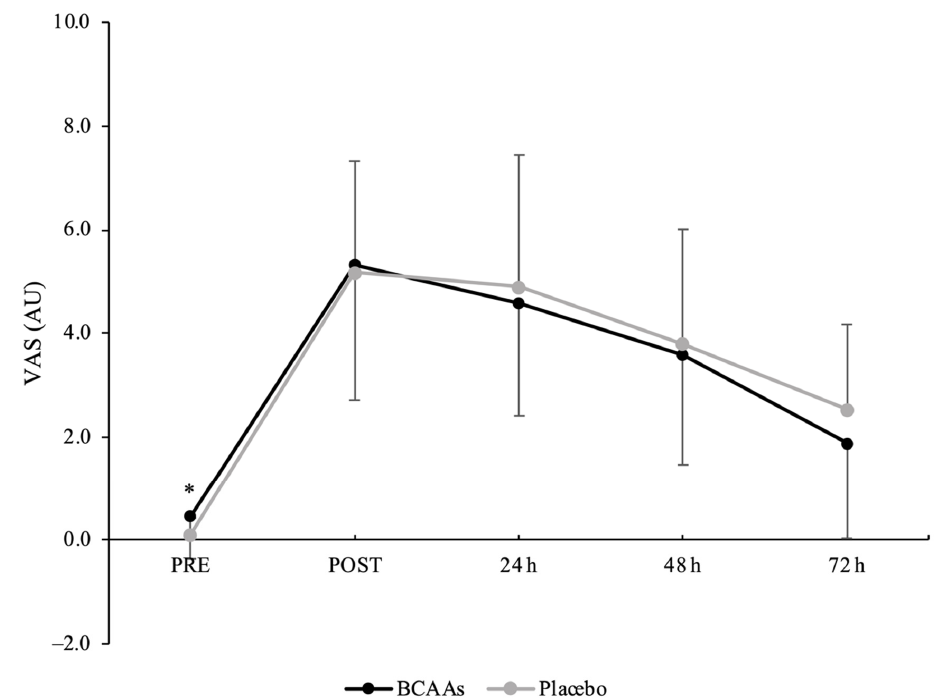
Figure 5. Muscle soreness scored by visual analog scale (VAS) during the time course of recovery. (*) Denotes differences ( p < 0.05) from all time-point measurements.